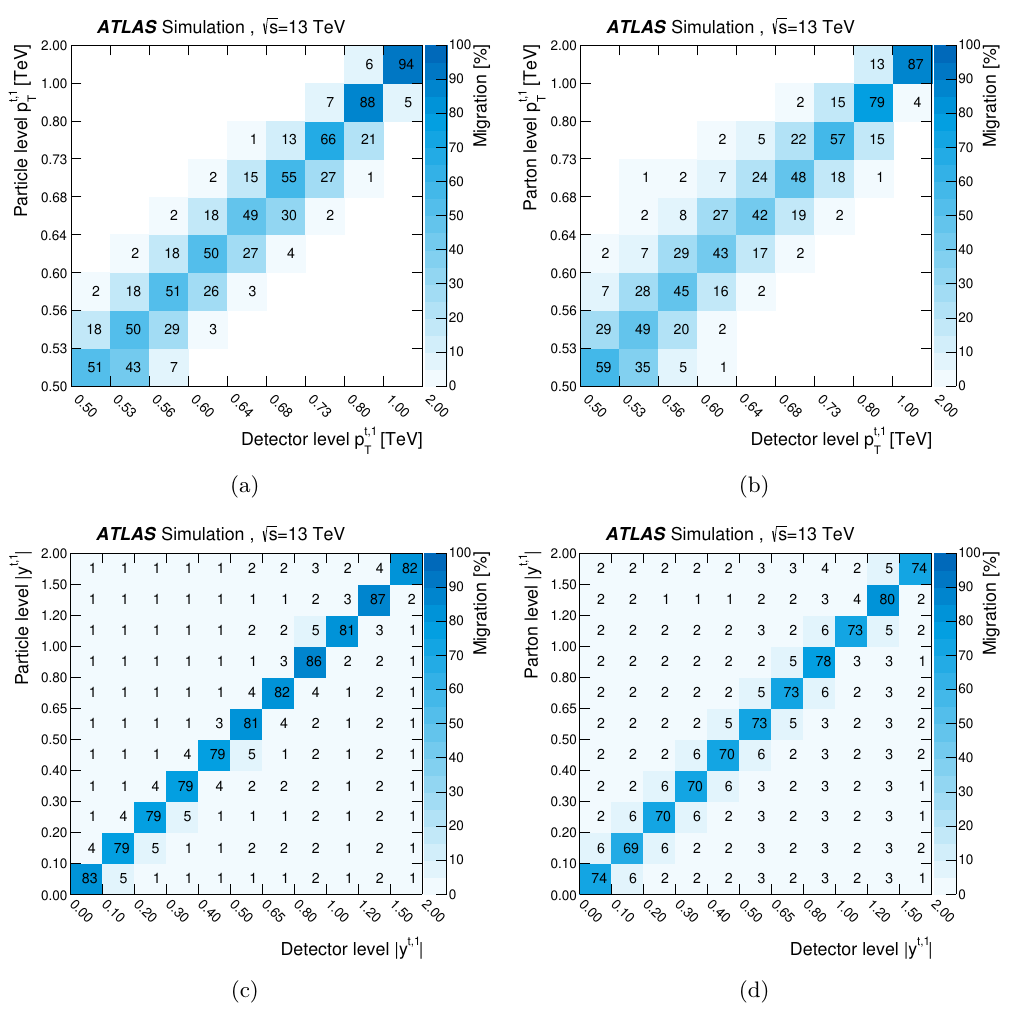
Figure 6 . Migration matrices for p T and | y | of the leading top-quark jet for the particle-level fiducial phase space in (a) and (c), respectively, and for the parton-level fiducial phase space in (b) and (d), respectively. Each row is normalized to 100%. The Powheg + Pythia 8 generator together with the Geant4 detector simulation framework is used to determine these